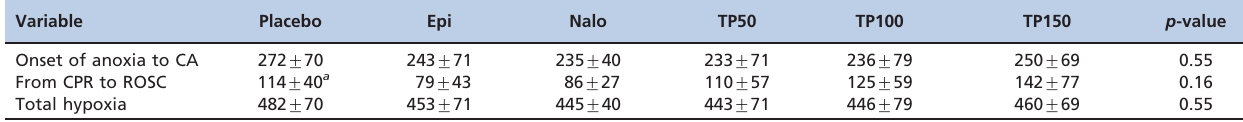
The values represent the mean ¡ SD. a Data from four animals (three animals did not present